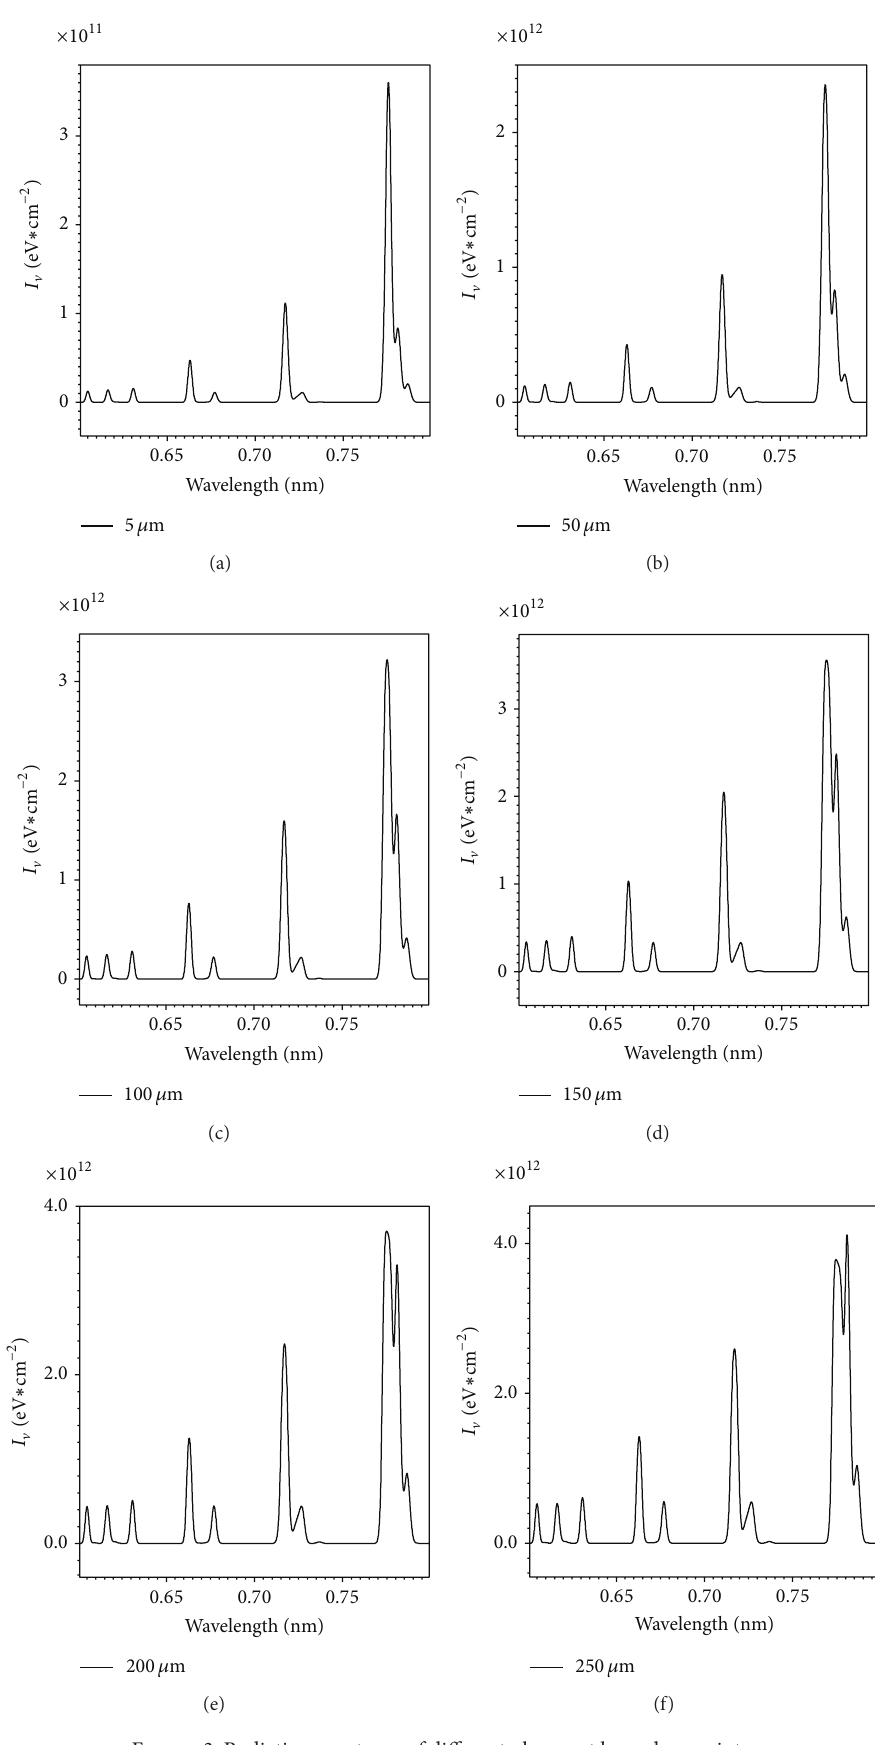
Figure 3: Radiation spectrum of different plasma at boundary